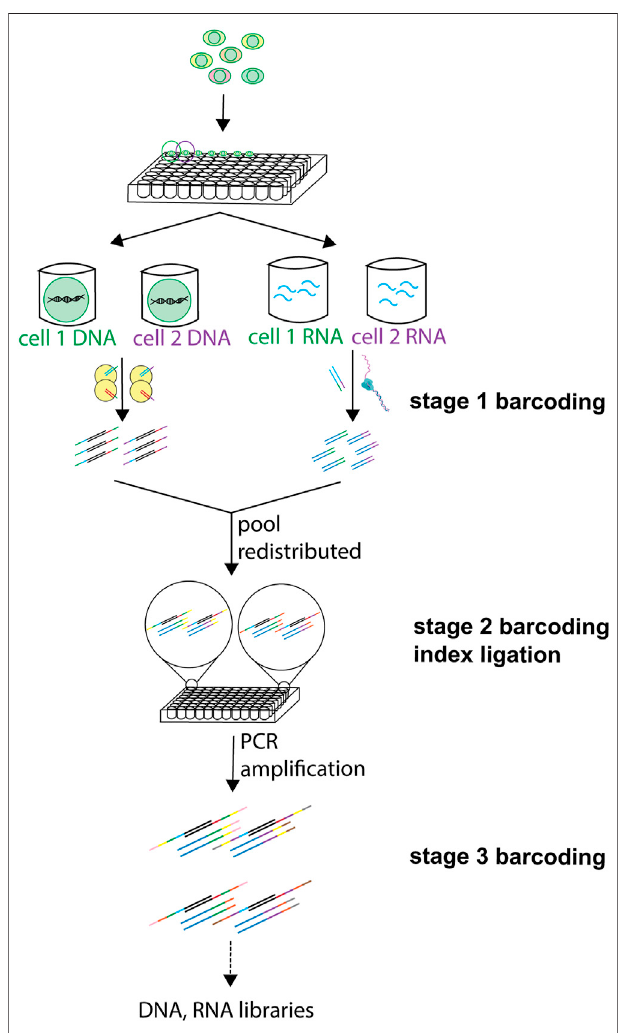
FIGURE 3 | Use of barcoding at different steps in sc-multiomics. Barcoding of DNA and RNA can be employed at different steps of the processing of single cells, and different labels and techniques can be used at oneormoreofthesesteps.A fi rstbarcodecanbeinsertedinDNAduring tagmentation and in RNA during RT. Then, after pooling of samples and redistribution into wells, one or more ligation-based barcoding is possible. A third barcoding is possible during ampli fi